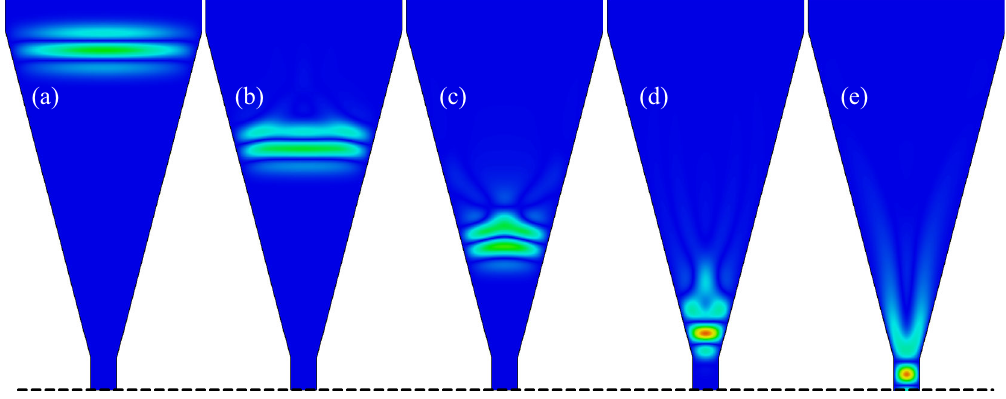
FIG. 6. E-field distributions of the THz pulse focusing in a tapered waveguide at consecutive time steps from the time the pulse arrives at the horn (a) to when it is focused (e).